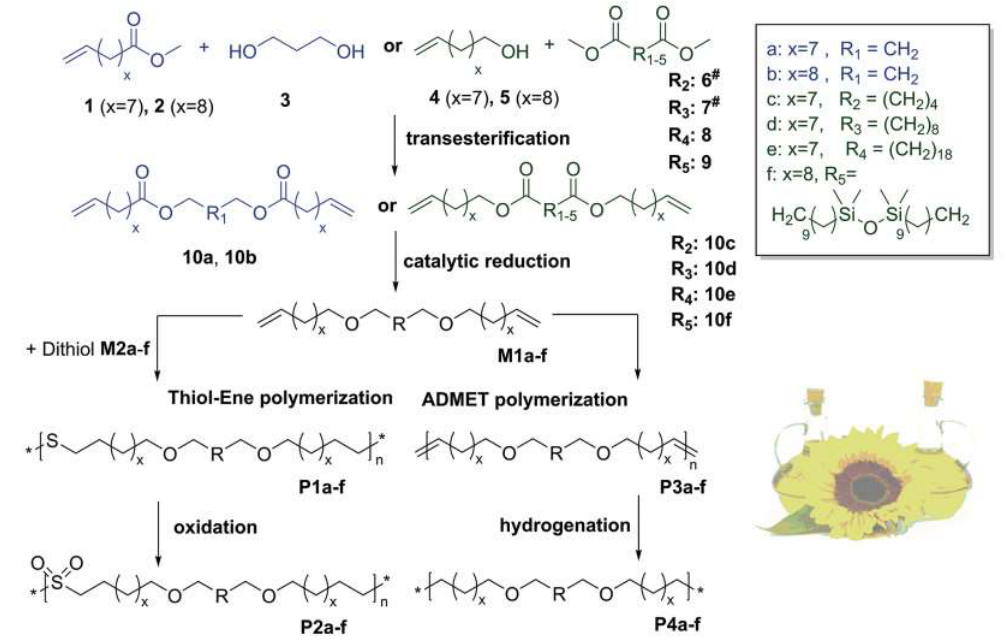
Figure 27. An example of performing the Ht and Hs reactions with natural substrates. Reproduced with permission from Ref. [125]. Copyright 2019 John Wiley and Sons.